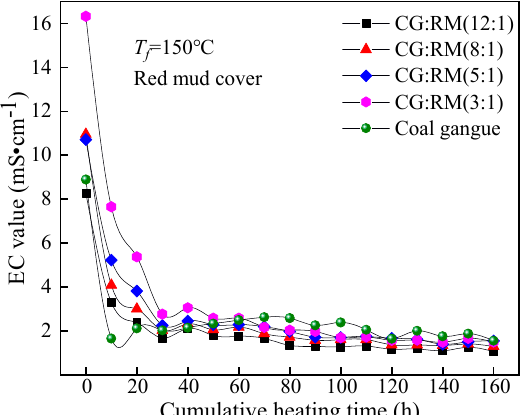
Figure 9. Variations of EC value of co-disposal leaching solution with different mass ratios.